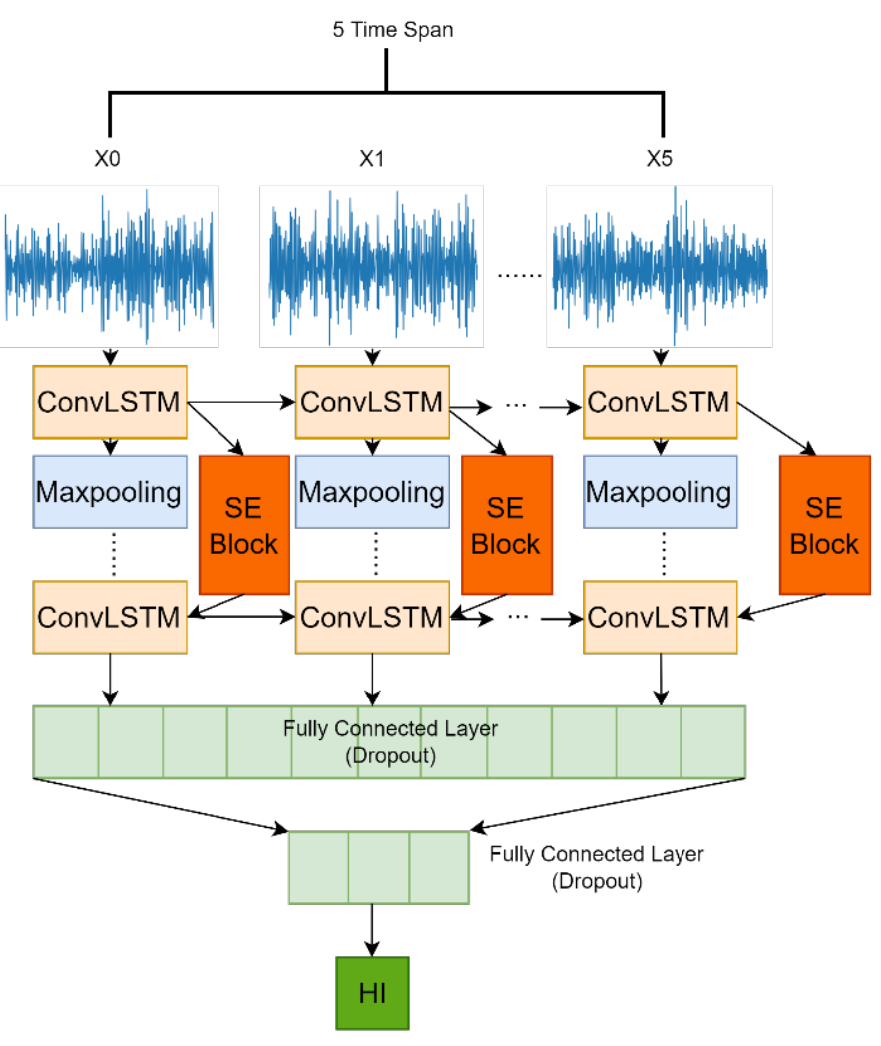
Figure 3. Schematic diagram of SE-ConvLSTM neural network.